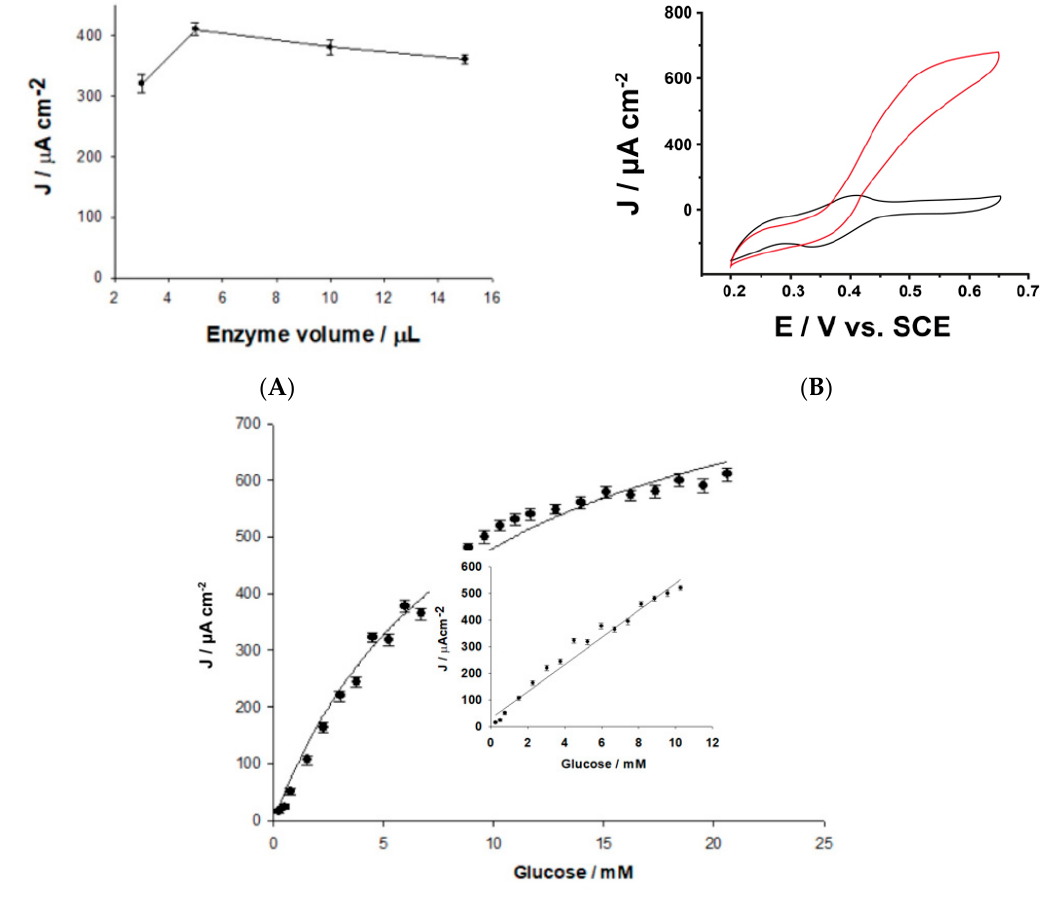
Figure 5. ( A ) Effect of enzyme loading on biosensor response; ( B ) Cyclic voltammogram of the FAD- GDH/FcSH/h-PG microneedles-based electrode in the absence and in the presence of glucose; ( C ) The calibration curve of the glucose biosensor; inset: linear range. Experimental conditions: artificial interstitial fluid (ISF) pH 7.5; E = 0.5 V versus SCE.